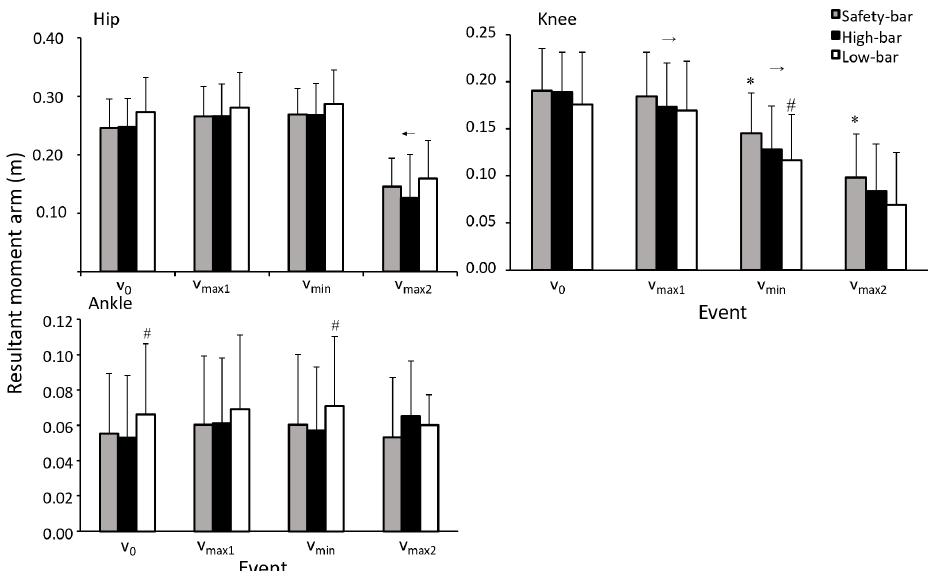
Figure 5. Mean (±SD) hip, knee, and ankle moment arms at the events v max1 , v min , and v max2 for the high-bar, low-bar, and safety-bar squat during 3-RM. * indicates a significant difference between this squat condition and low-bar squat on a p ≤ 0.05 level. † indicates a signi fi cant decrease from v min to v max2 for all squat conditions on a p ≤ 0.05 level. # indicates a significant difference between this squat condition and the high-bar condition on a p ≤ 0.05 level. → or ← indicates a significant difference between this event and all the other events for all squat conditions on a p ≤ 0.05 level.